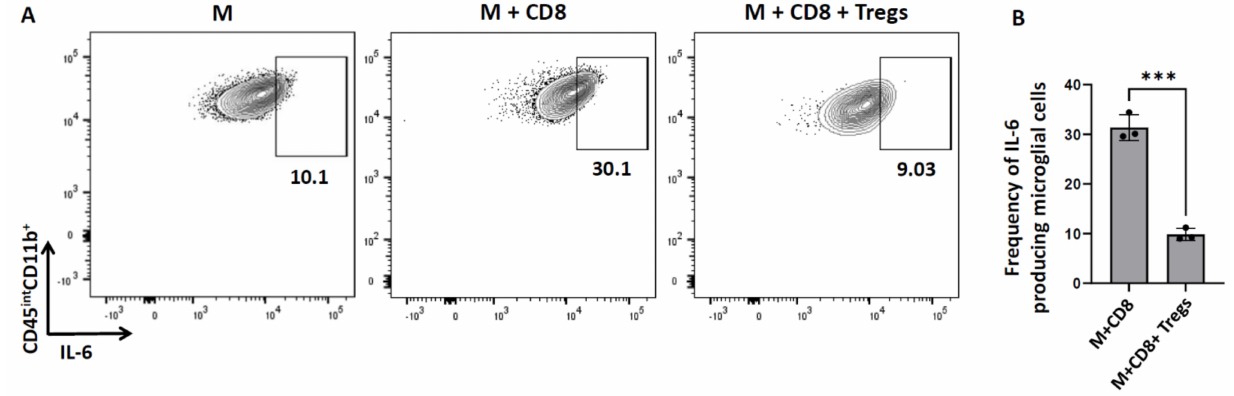
Figure 4. Tregs modulate microglial cell production of IL − 6 . Microglial cells were trypsinized from the in vitro cytotoxicity assay plates and further analyzed for IL − 6. ( A ) Representative con- tour plots show production of IL − 6 by microglia (CD45 int CD11b + ). ( B ) Bar graph showing the frequency of IL − 6 − producing microglial cells. Data shown are representative of three experi- ments using 3 wells/group/experiment and expressed as mean ± SE. rAd-OVA-primed OT-1 mice ( n = 2/experiment) and IL − 2/anti − IL − 2-injected C57BL/6 mice ( n = 4/experiment). *** p <